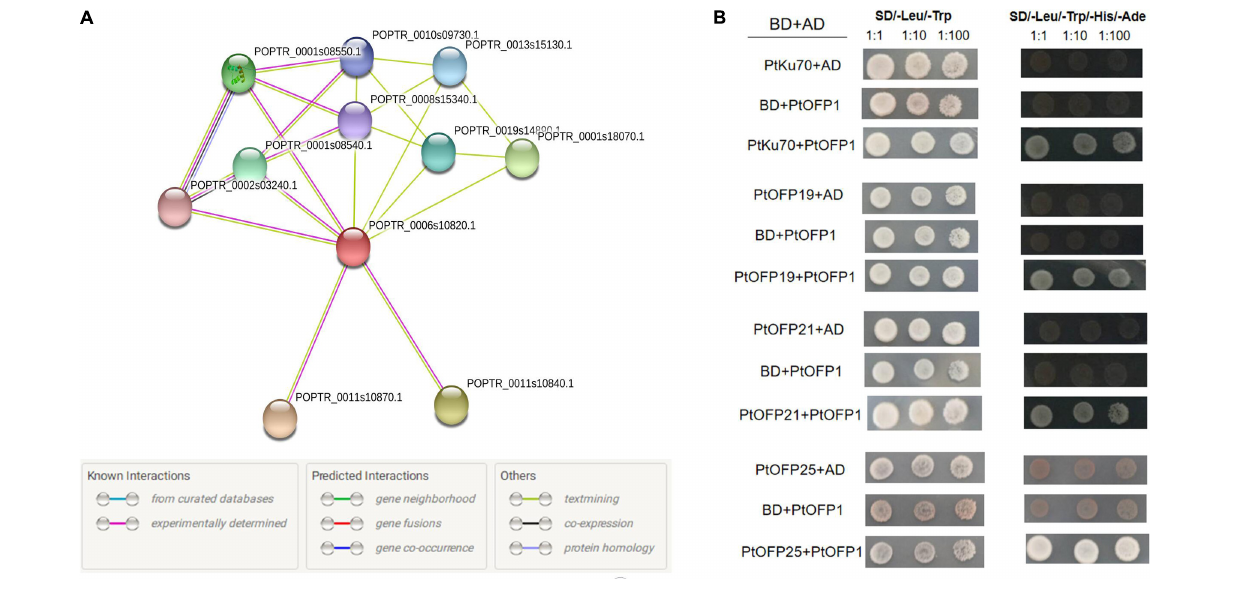
FIGURE 6 | Functional protein association network and yeast two-hybrid assay. (A) Protein interaction network analysis revealed 10 potential proteins that may interact with PtOFP1. Line colors indicate the different kinds of evidence used to predict the network of protein interactions. (B) Yeast two-hybrid analysis of protein–protein interactions of PtOFP1 proteins. AD and BD represent empty pGADT7 and pGBKT7 vectors, respectively. SD/-Leu/-Trp represents the synthetic dextrose media (SD) lacking Leu and Trp. SD/-Leu/-Trp/Ade/-His/-Ade indicates SD medium lacking Leu, Trp, Ade and